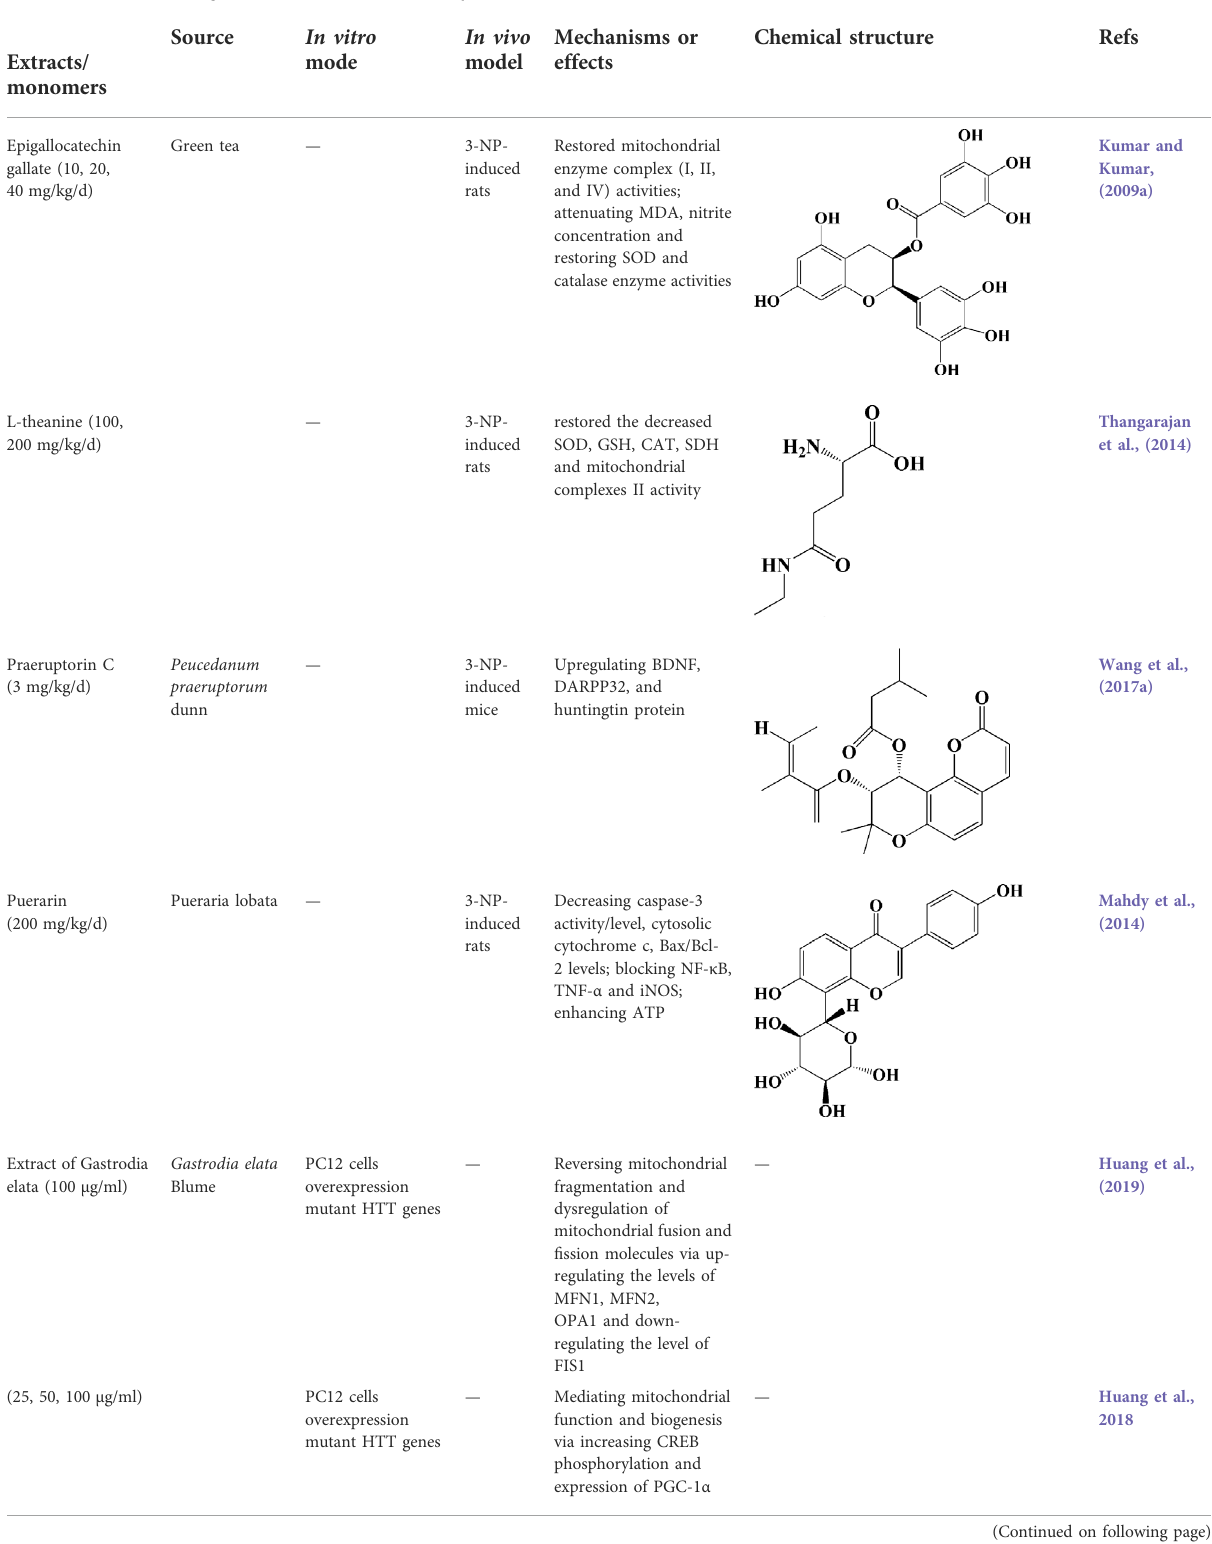
TABLE 2 Mitochondrial dysfunction-associated natural products for